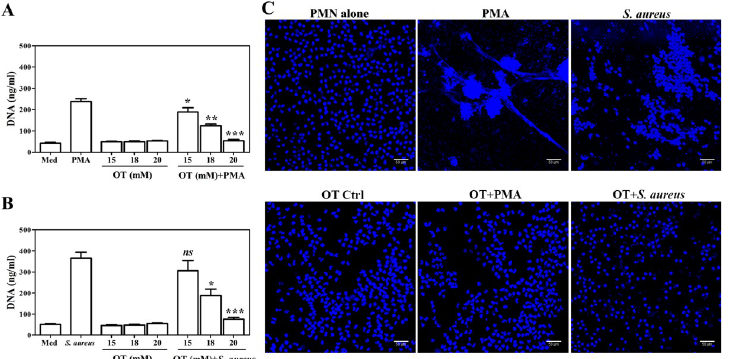
Fig 3. The reduction of NET releases by pretreatment with oxythiamine. PMNs were preincubated with increasing concentrations of oxythiamine, a TKT inhibitor (15, 18, and 20 mM) at 37˚C for 60 min. (A) 100 nM PMA or (B) S . aureus at a MOI of 10 was then added into the cultures at 37˚C and 5% CO 2 for 90 min. The amount of extracellular DNA was quantified using the Picogreen dsDNA kit. The data shown are representative of four independent experiments (n = 4). The horizontal line denotes mean ± SEM. Statistically significant P -values are indicated as follows: � p < 0.05, �� p < 0.01, ��� p < 0.001, and NS-non significant. (C) The effect of oxythiamine on NET release by fluorescent images, cells were fixed with 4% PFA and then stained with membrane-permeable DNA-binding dye, DAPI. The representative microscopic images illustrated controls and stimulated PMNs with PMA or S . aureus after 20 mM oxythiamine treatment. Photomicrographs are of representative cells from three independent experiments. Magnification: 10 × or 20 × ; scale bars: 50 μ M. OT; oxythiamine.